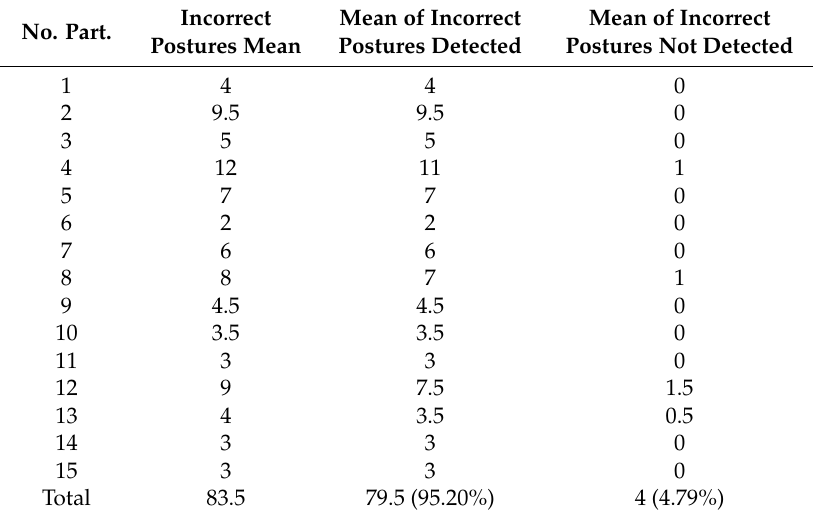
Table 2. Mean performance of the posture recognition system for both sessions. No.